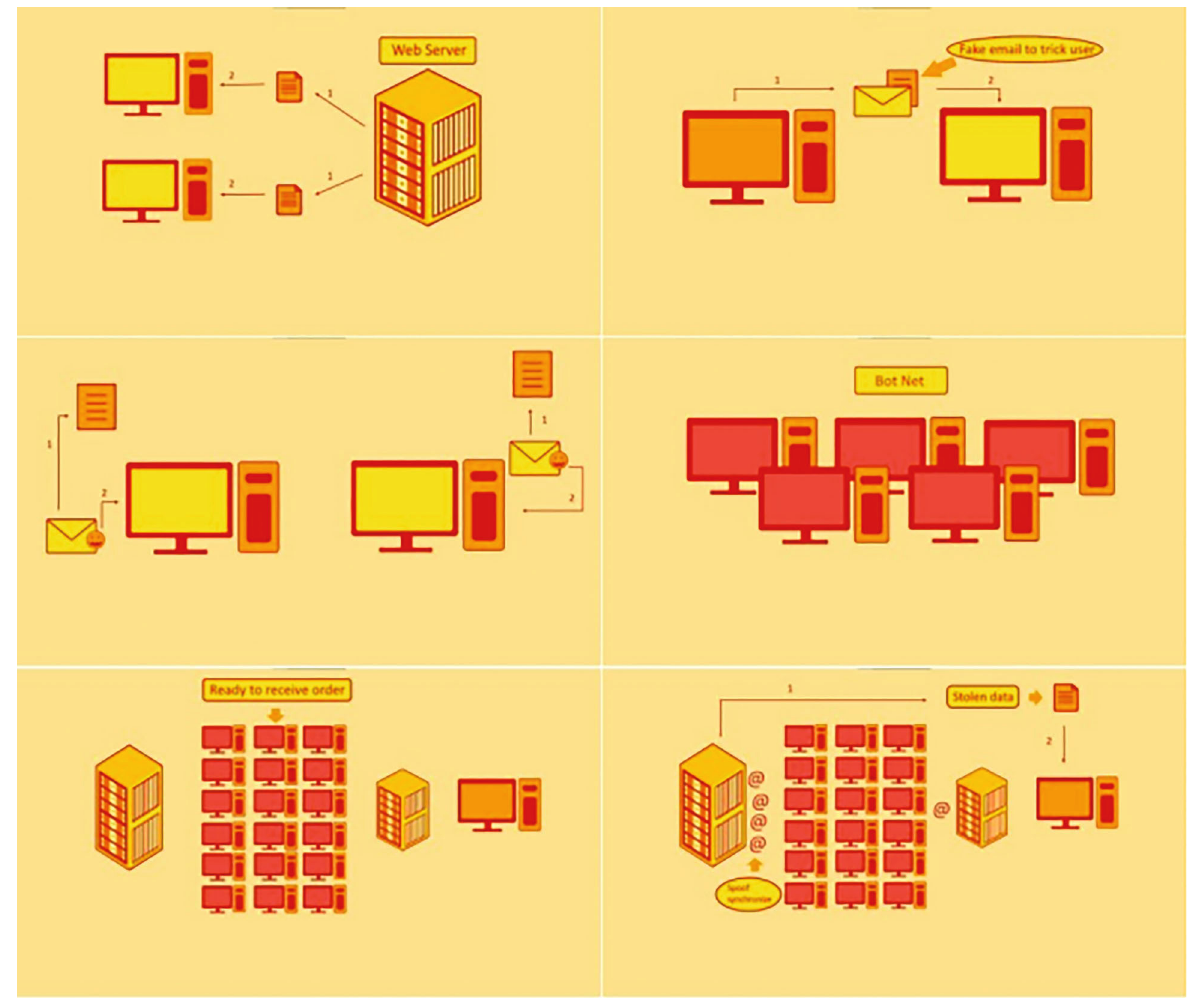
Figure 1: Sample multimedia learning visuals using warm color